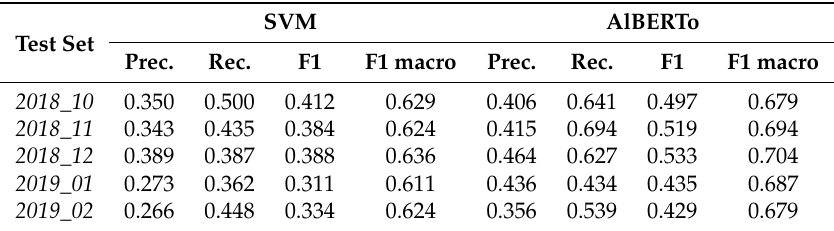
Table 5. Numerical results of the evaluation of the model trained on Incremental (no Haspeede+) dataset. SVM AlBERTo Test Set Prec. Rec.